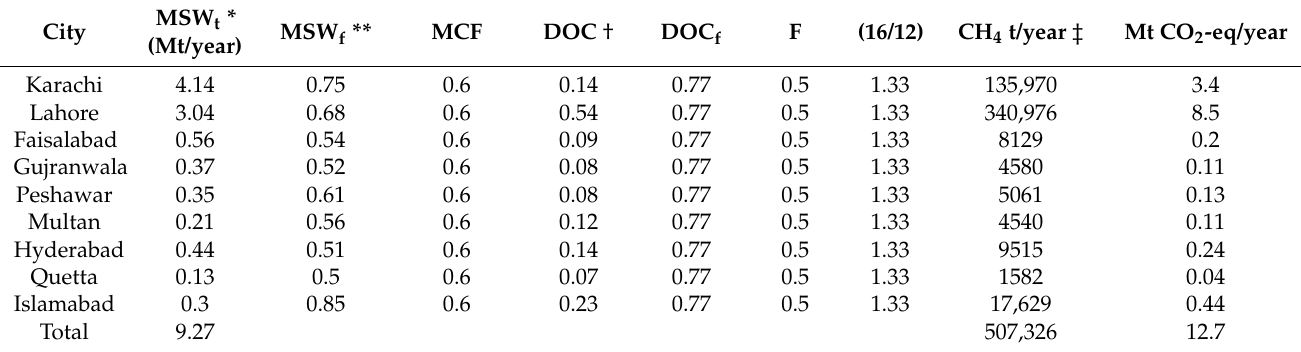
Table 8. Estimated CH4 production from waste disposal sites in the most populous cities in Pakistan.